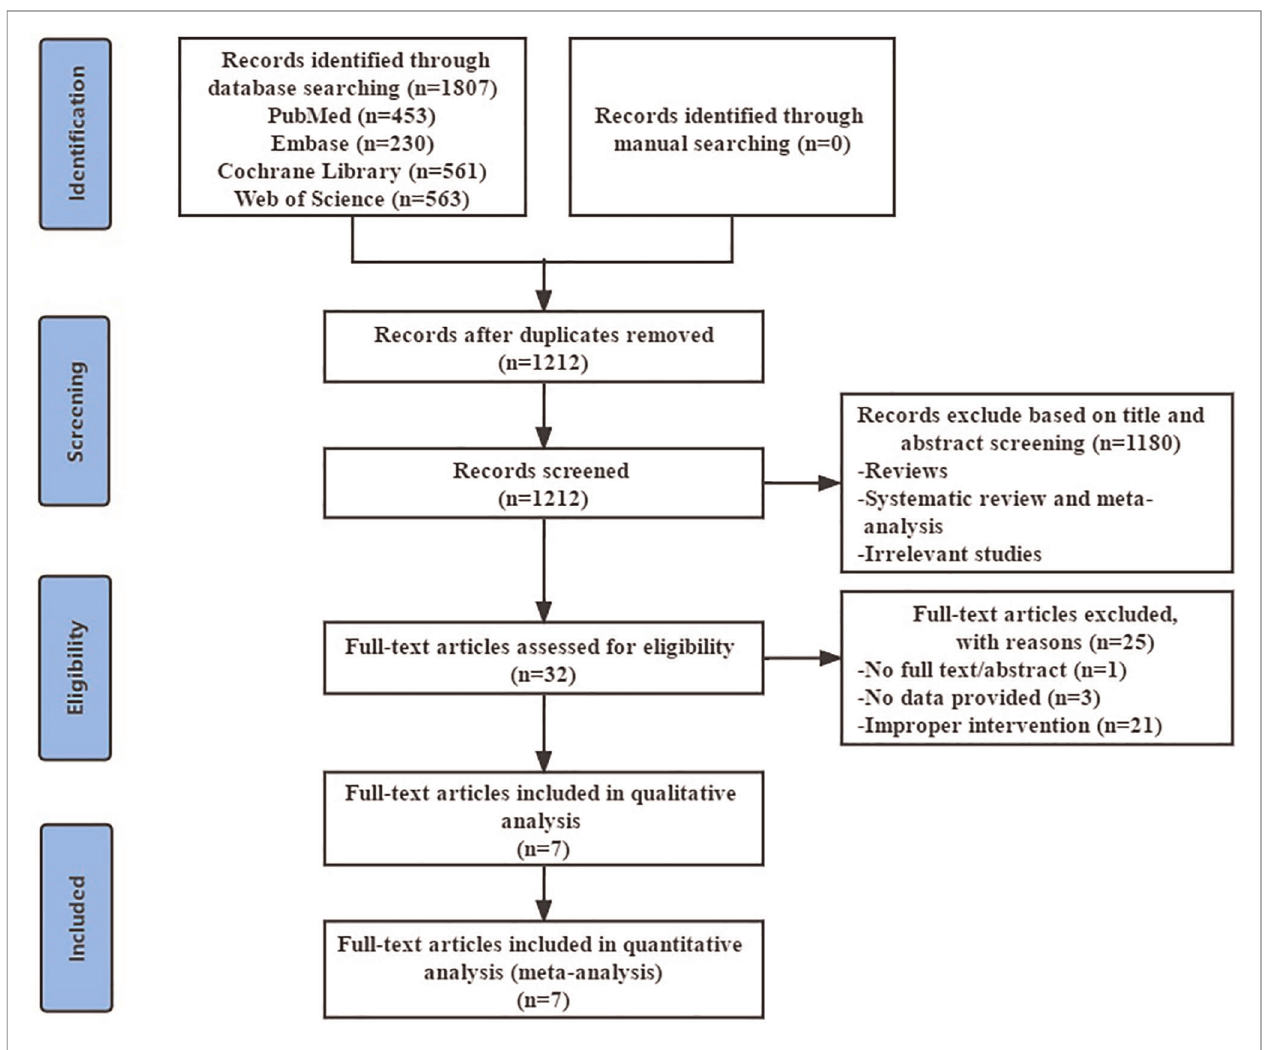
FIGURE 1 | Flowchart of study